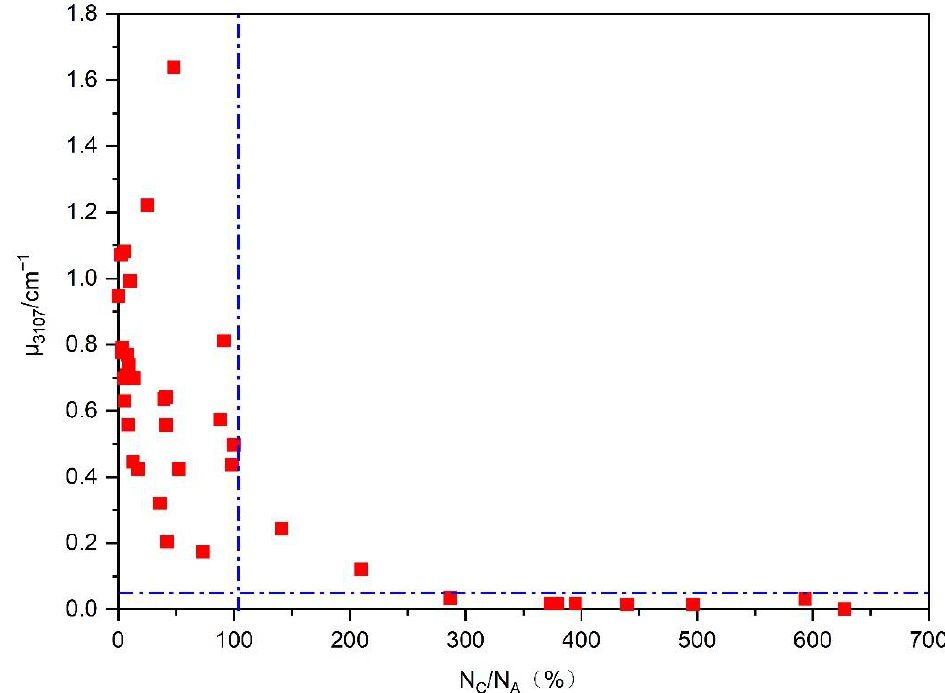
Figure 2. Relations among the concentration of single nitrogen, aggregated nitrogen and the inten- sity of 3107 cm −1 optical centers in natural type Ib diamond. When the ratio of N C /N A is less than 1 (the left areas of the vertical dash-dotted line), the 3107 cm −1 absorption is evident. When the ratio of N C /N A is greater than 3, the 3107 cm −1 absorption coefficient is less than 0.05 cm −1 (region below the horizontal dash-dot line).